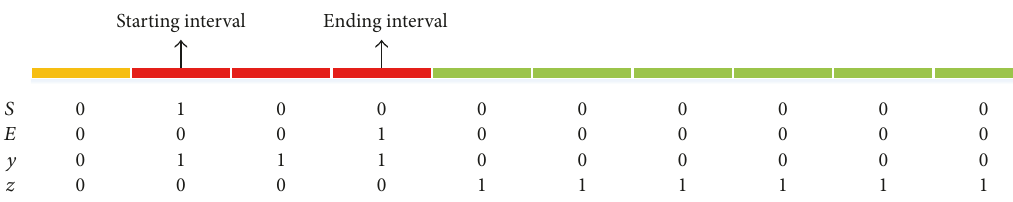
can be specified by a series of conditional constraints.